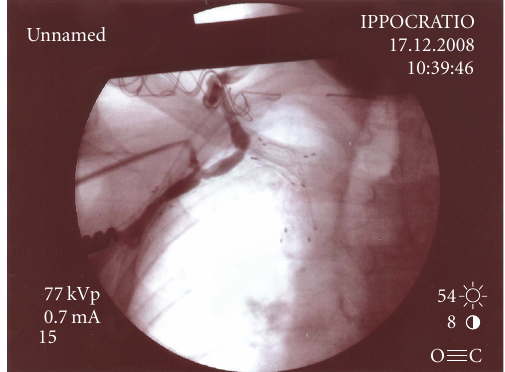
Figure 3: A long, slittable, guiding catheter is advanced to the right atrium and through the tricuspid valve to the right ventricle.